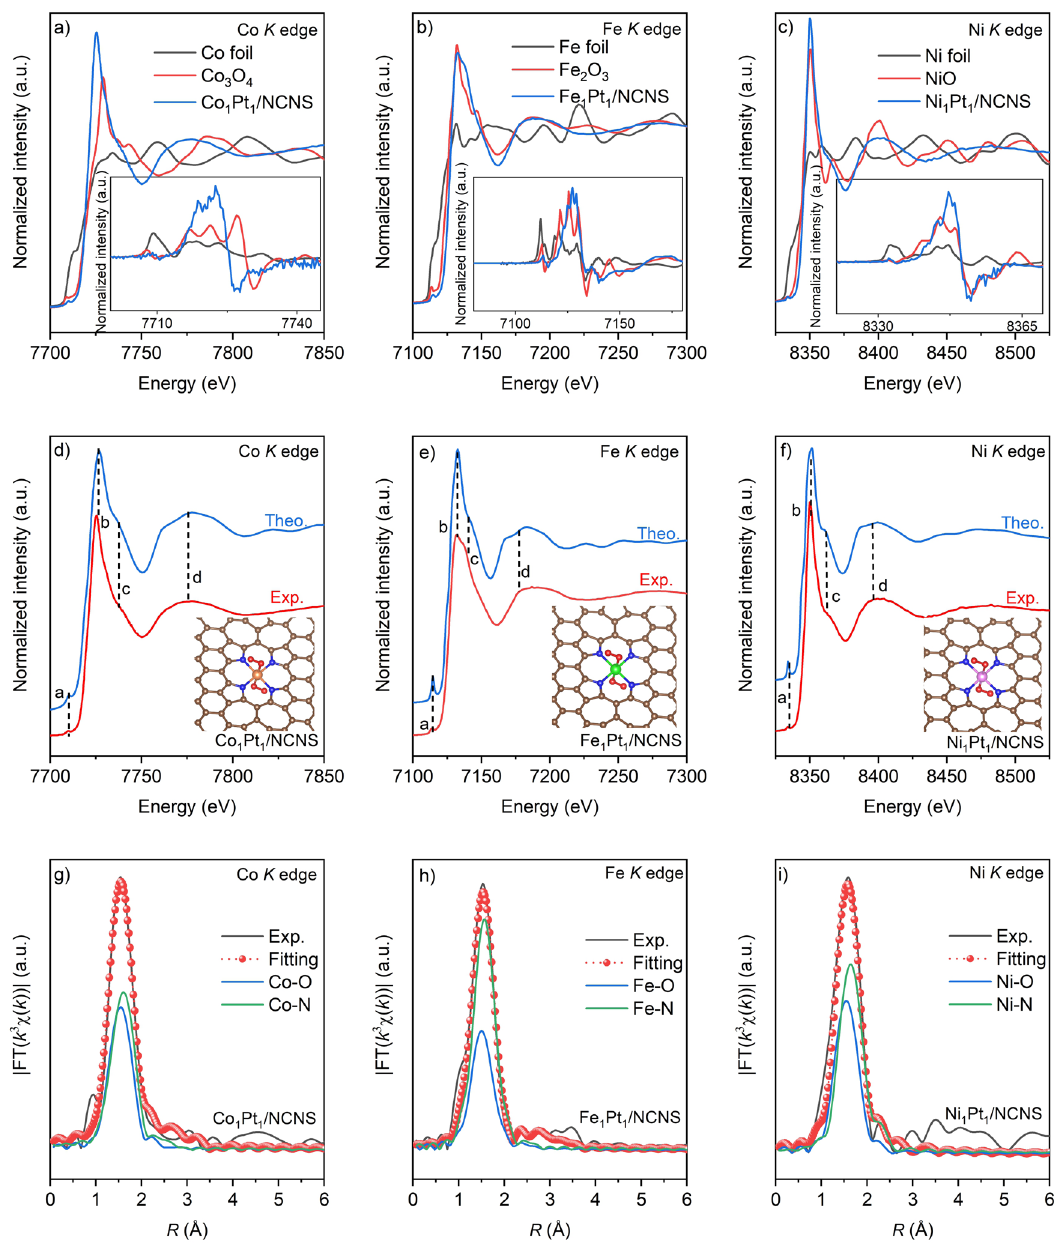
Fig. 4 Identi fi cation of the local structure of M 1 Pt 1 /NCNS catalysts. a – c The experimental K -edge XANES spectra and fi rst derivative curves (insets) of M 1 Pt 1 /NCNS and references samples. d – f Comparison between the experimental K -edge XANES spectra of M 1 Pt 1 /NCNS and the simulated spectra. Some of the main features reproduced are highlighted at points “ a ” to “ d ” . Fitting results of the k 3 -weighted FT spectrum of M 1 Pt 1 /NCNS at Co ( g ), Fe ( h ), and Ni ( i ) K edges. The white, brown, blue, red, orange, green, and pink spheres represent H, C, N, O, Co, Fe, and Ni,